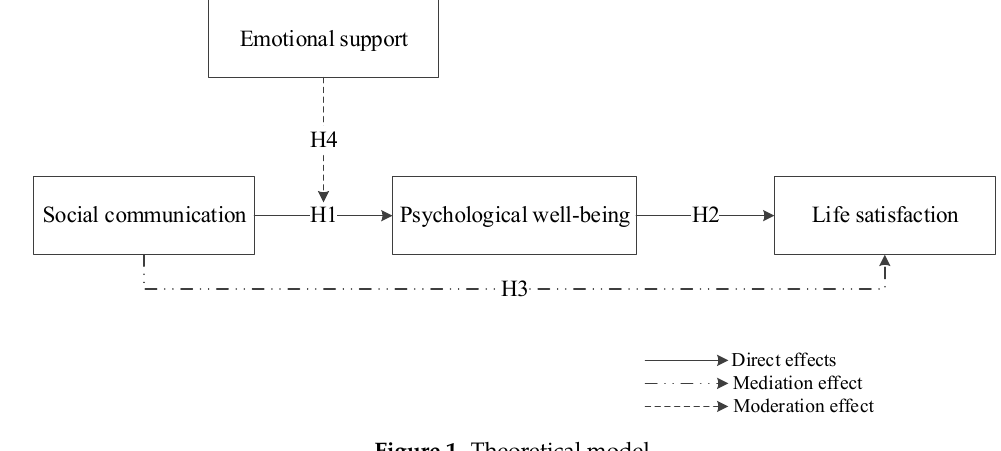
Figure 1. Theoretical